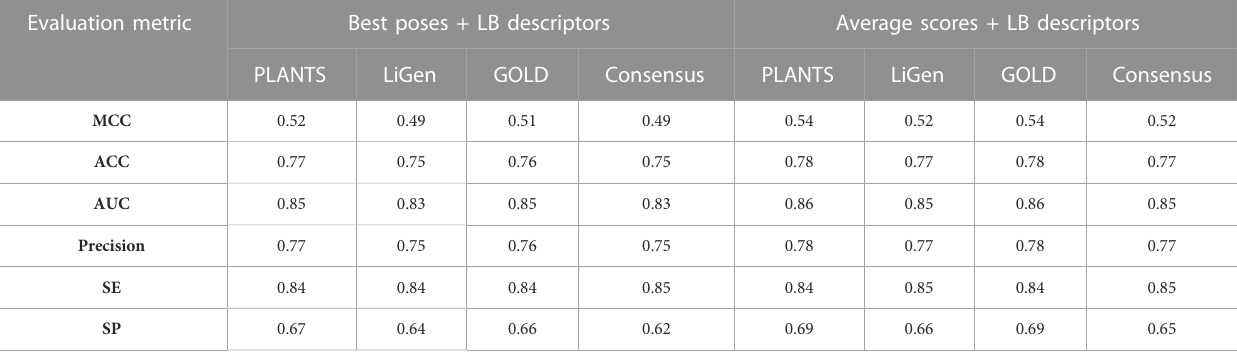
TABLE 3 MCC, Accuracy (ACC), AUC, Precision, Sensitivity (SE) and Speci fi city (SP) values of the classi fi cation models generated by combining the LB descriptors with the scoring functions calculated from each docking and rescoring calculation. Evaluation